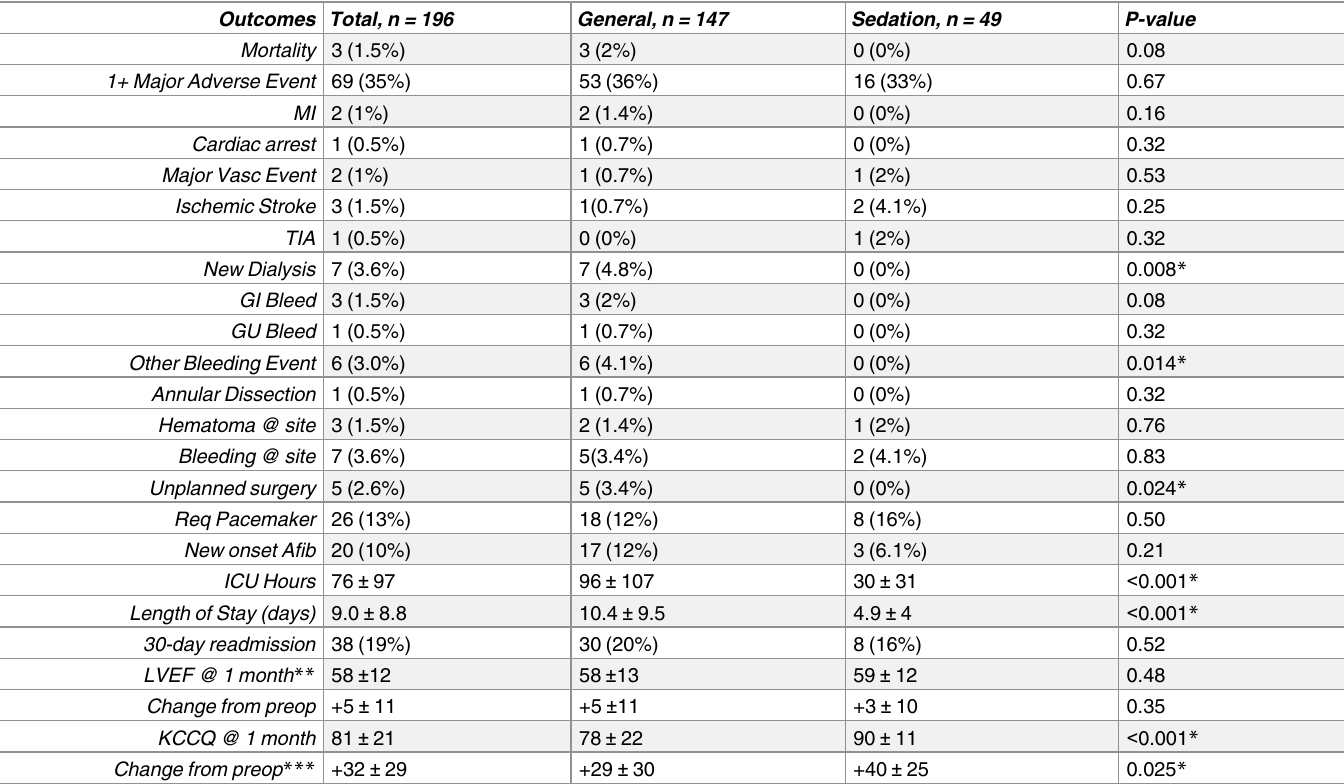
Table 2. Clinical outcomes, all matched patients.